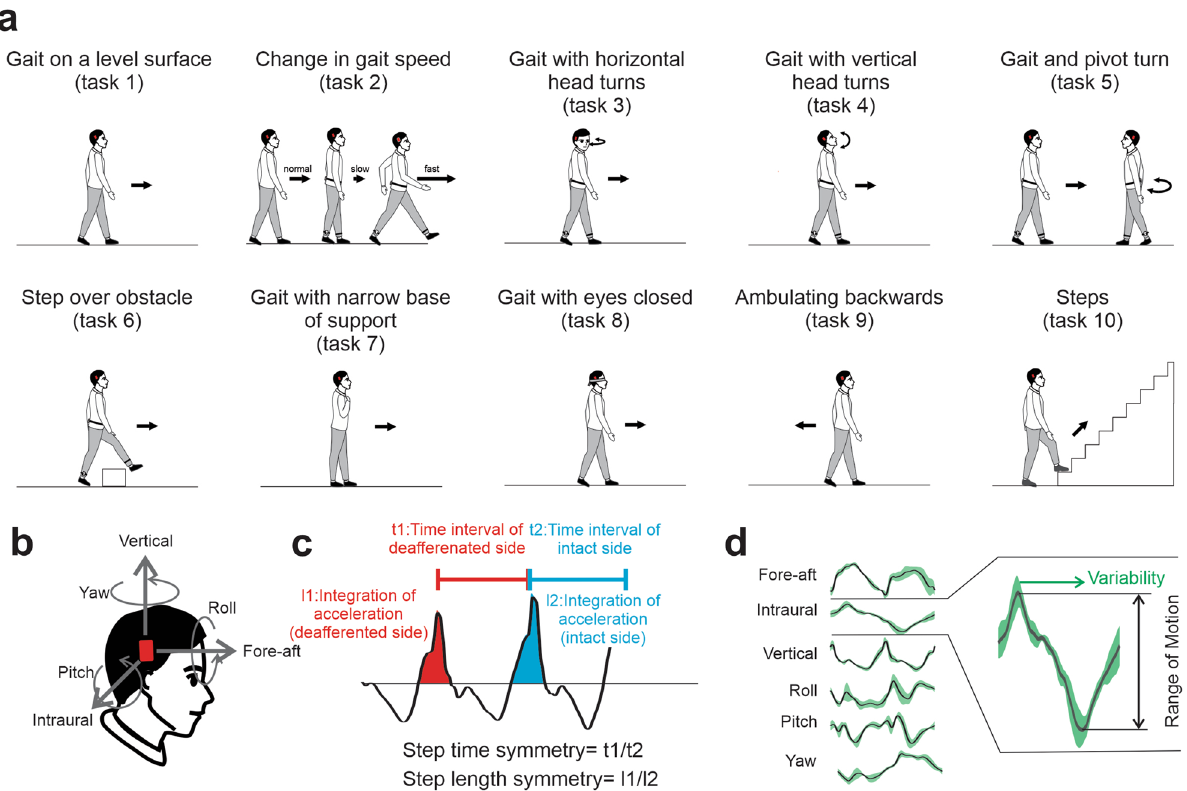
Figure 1. ( a ) Schematic of 10 Functional Gait Assessment (FGA) tasks: (1) ‘gait on a level surface’, (2) ‘change in gait speed’, (3) ‘gait with horizontal head turns’, (4) ‘gait with vertical head turns’, (5) ‘gait and pivot turn’, (6) ‘step over obstacle’, (7) ‘gait with narrow base of support’, (8) ‘gait with eyes closed’, (9) ‘ambulating backwards’, and (10) ‘steps’ ( b ) Subjects’ head motion during FGA was recorded using a MEMS sensor attached to their head which comprises three linear accelerometers (recording linear accelerations along the fore-aft, interaural, and vertical axes) and three gyroscopes (recording angular velocity about pitch, roll, and yaw). ( c ) Asymmetry measures defined as 1) ‘step time asymmetry’, estimated from the time intervals between vertical acceleration peaks for each leg’s heel strike was calculated and 2) ‘step length asymmetry’, estimated as the integration of the positive vertical accelerations following heel strike of each leg was calculated. ( d ) Variability and range of motion were quantified for each of the six axes of head motion as the average of the standard deviation and magnitude of the signal across gait cycles in each (“sub-acute post-op”) and > 6 months after surgery (“chronic post-op”). Comparison across populations and time points revealed lower time constants for patients in each state, relative to controls ( p < 0.0001). Following surgery, patients showed a significant decrease in time constant relative to pre-op values ( p < 0.05) which returned to val- ues not significantly different than those recorded in the pre-op or sub-acute values ( p > 0.05). In contrast, analysis of VOR gains revealed no difference between healthy controls and pre-op patients ( p > 0.05), but patients then showed significantly lower gains after surgery (i.e., sub-acute state, p < 0.05) that then returned to pre-op values in the chronic state ( p > 0.05). Each subject’s functional capacity was also scored using the conventional FGA test evaluated by a clinician (an integer value between 0 and 3 was assigned to each of the 10 tasks). Figure 2b demonstrates that the patients’ FGA scores were significantly worse than those of healthy controls at each of the 3 time points (i.e., pre-op, sub-acute, and chronic, p < 0.0001). We further found that FGA scores did not differ for patients when compared across each of these 3 measured time points ( p > 0.05). Specifically, patient scores were comparable in the sub-acute compared to the pre-op state and then remained unchanged even after 6 months. Head movement kinematics are abnormal in VS patients. To quantify subject performance dur- ing each FGA task, we first quantified head movement kinematics (see “Methods”) during the two tasks where individual gait cycles could not be reliably identified, the ‘gait with pivot turn (task 5)’ and ‘gait with narrow base of support’ (task 7). Our analysis of ‘Gait with pivot turn’ (task 5) did not reveal any significant differences in head kinematics between different groups. Specifically, both peak pivot velocity and post-pivot head accelera- tion were comparable to healthy controls for each patient at all three time points (Fig. 2c; p > 0.05). In contrast, during ‘gait with narrow base of support’ (task 7), our analysis revealed increased instability along the interaural axis (i.e., increased lateral sway) in all patient groups compared to healthy controls (Fig. 2d, * p < 0.05, ** p < 0.01). We also found that pre-op (but not post-op) patients were slower than normal in completing the task (Fig. 2d, Speed measure).